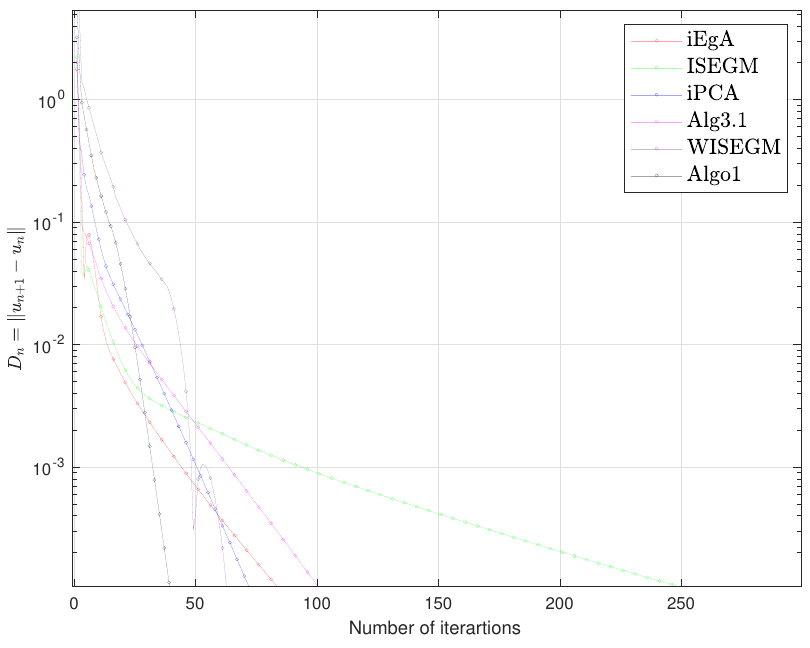
Figure 1. Example 1 in R 5 : Numbers of iterations are 85, 254, 73, 102, 63, 40 respectively.